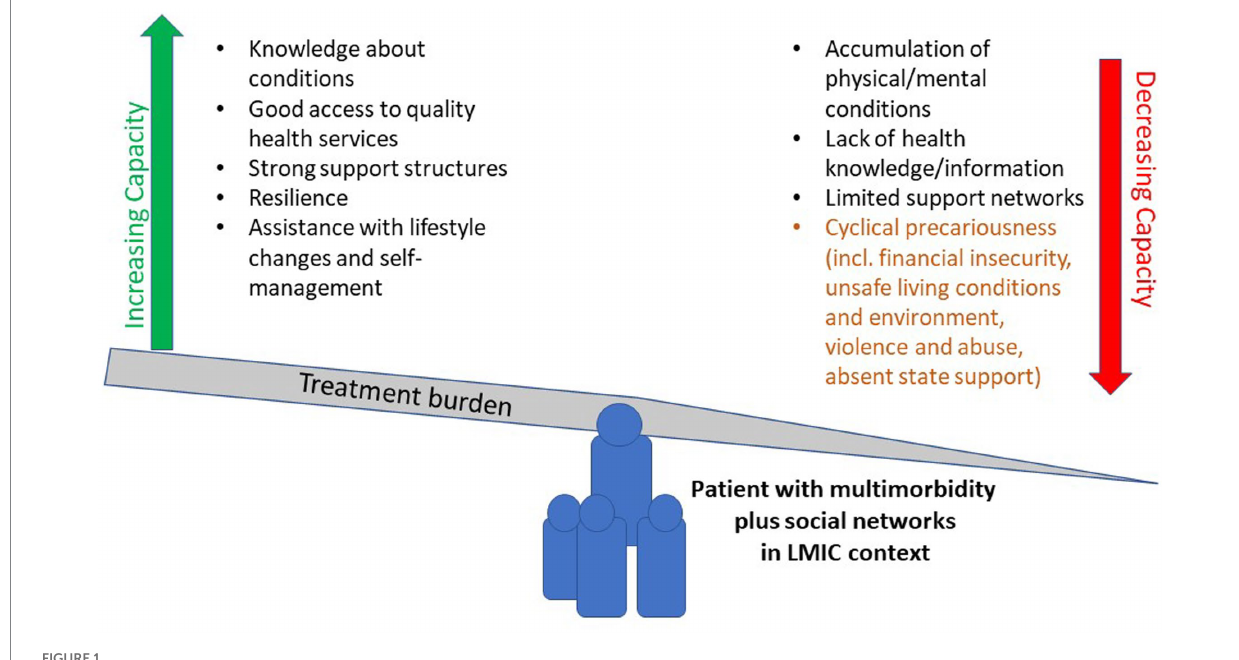
FIGURE 1 BoTT with the integration of cyclical